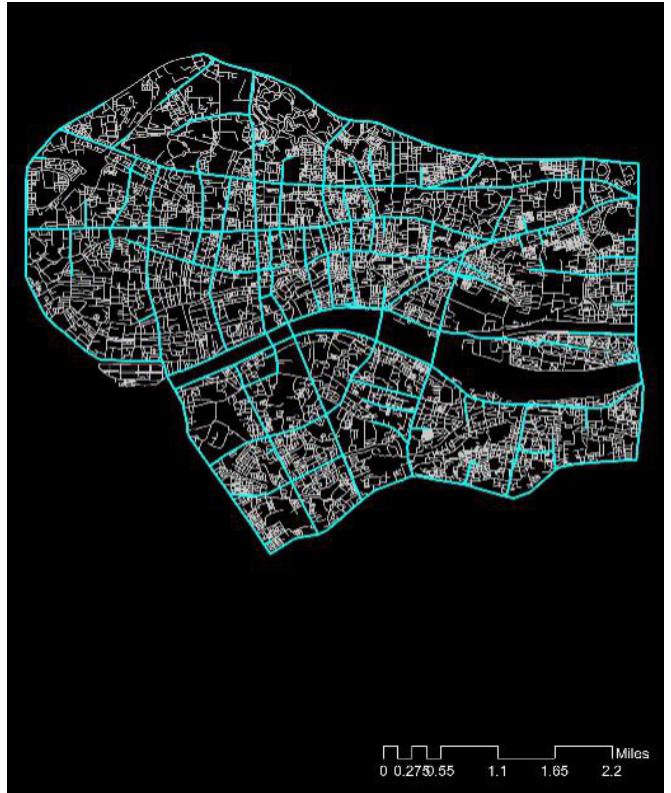
Fig. 18 Foreground network of